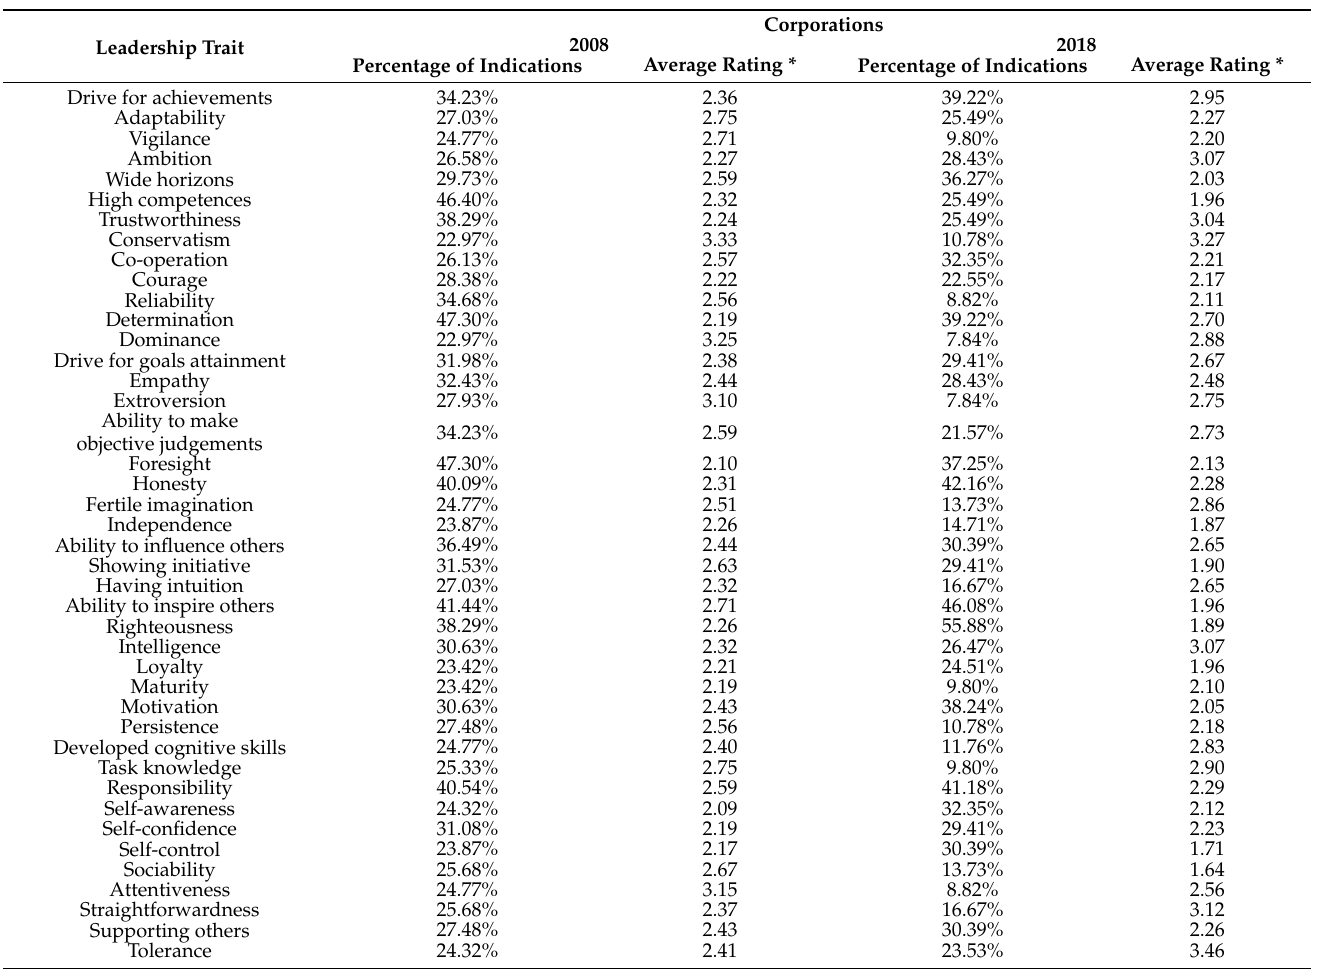
Table 3. Evaluation of the importance level of leadership traits as assessed by leaders of the Forbes Global 2000 world’s largest corporations—general context. Leadership Trait Drive for